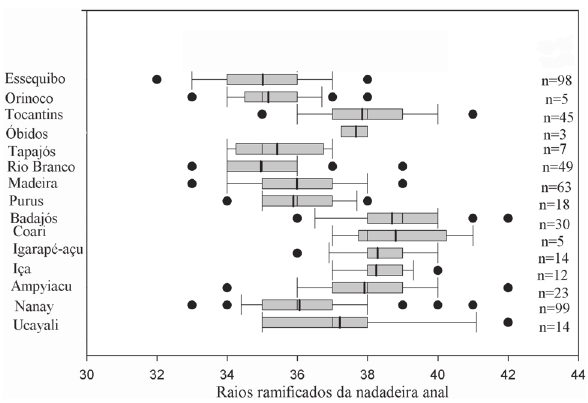
Figura 23. Variação do número de raios ramificados da nadadeira anal no complexo Phenacogaster pectinatus